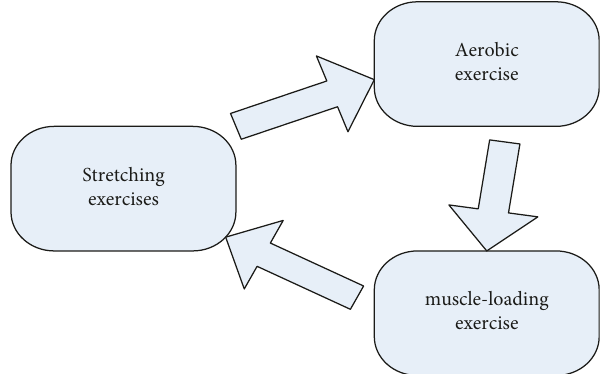
Figure 6: Bodybuilding and fitness exercise flow